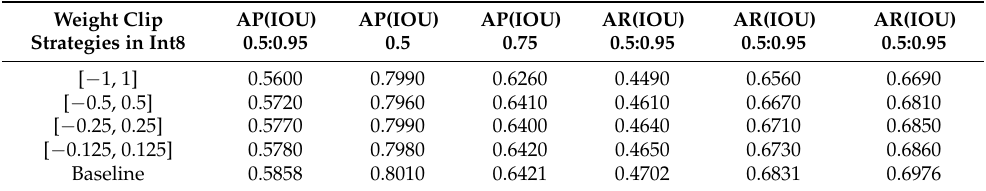
Table 3. Results of four weight clip strategies in int8 type during